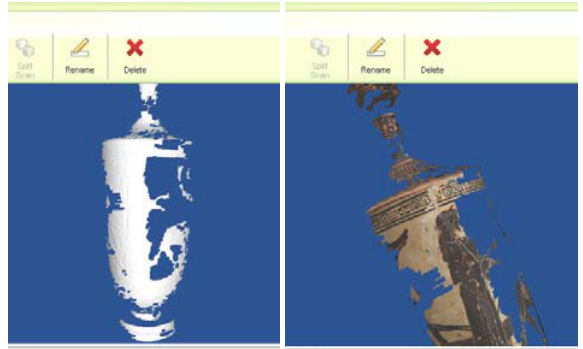
Fig. 3. Creation of the mesh (left) and the texture model (right) of a scan using XYZRGB